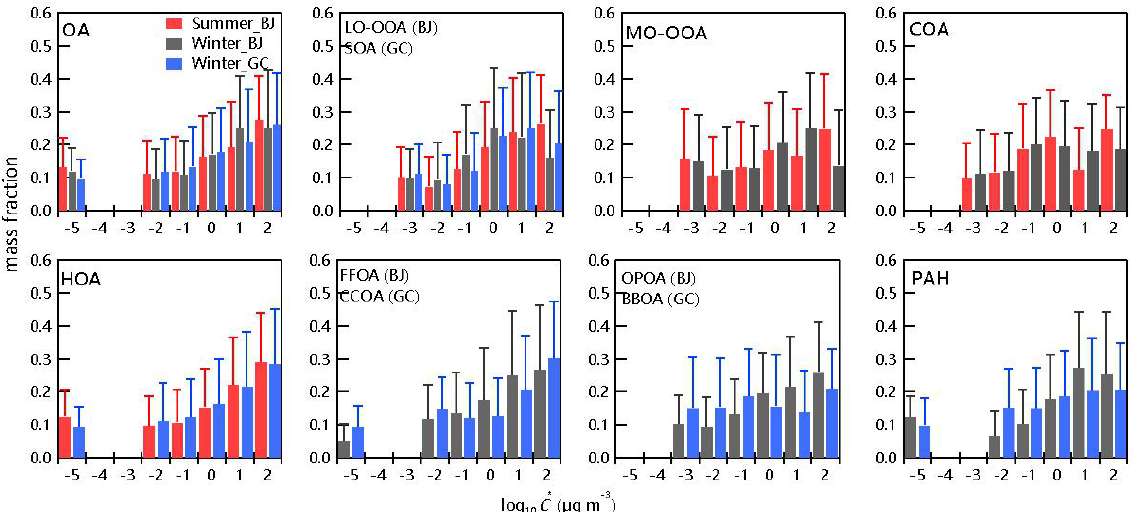
Figure 3. Predicted volatility distributions of OA, OA factors and PAH. The error bars are the uncertainties derived using the approach of Karnezi et al. (2014).